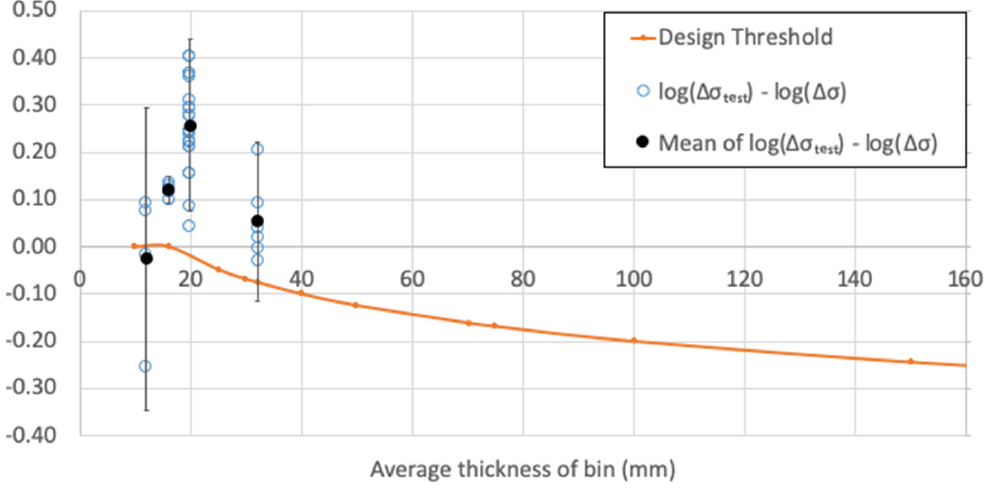
Figure 22. Data analysis of FC tubular Figure 24. Data analysis of FC tubular joints.